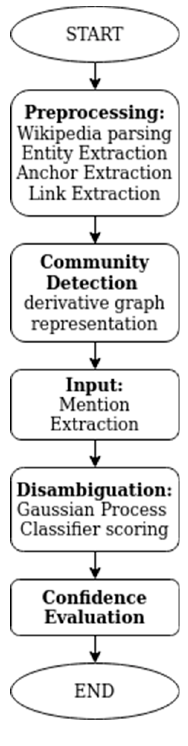
Figure 1. The proposed methodology flowchart.